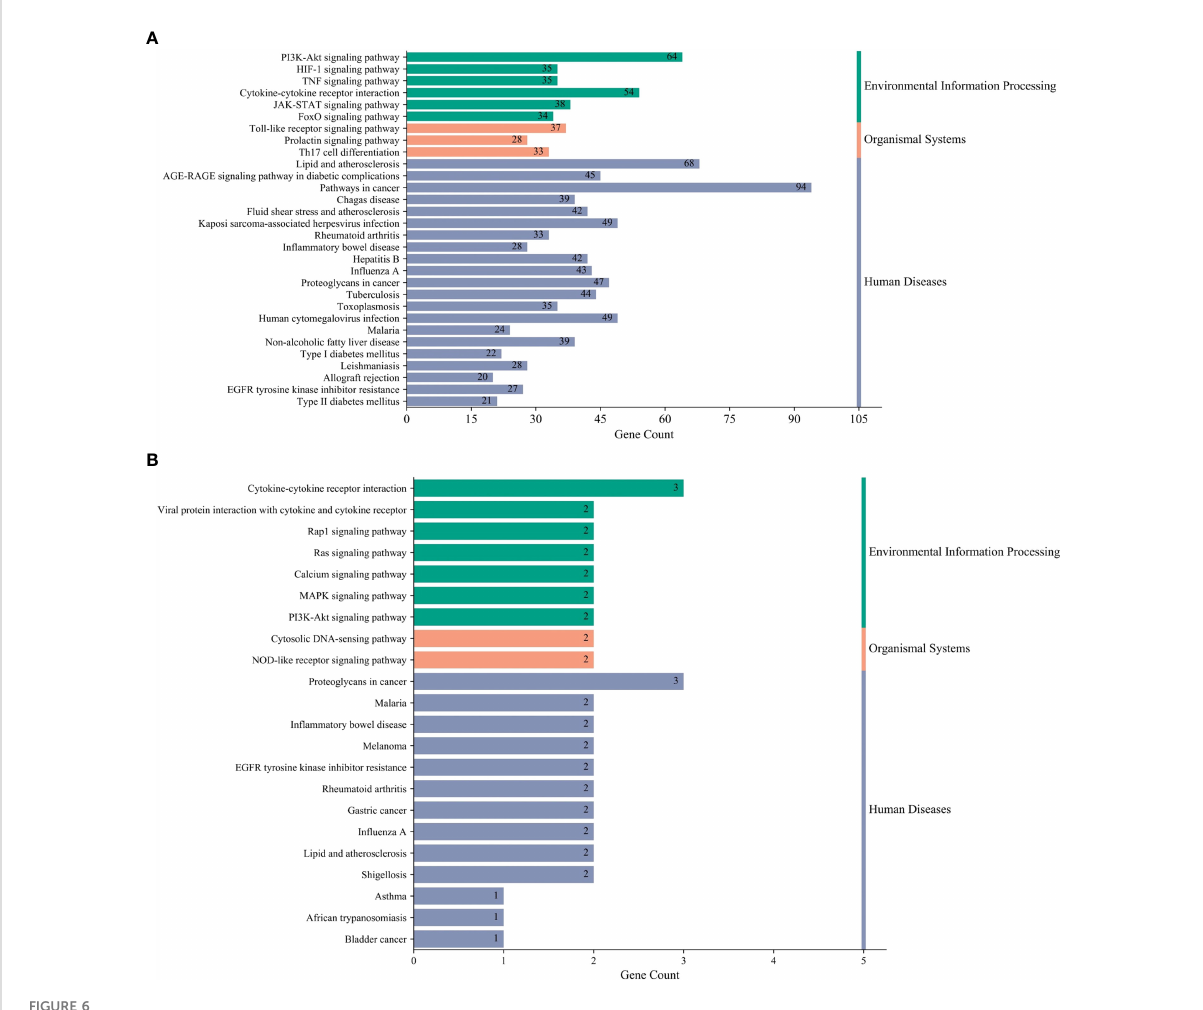
FIGURE 6 Kyoto Encyclopedia of Genes and Genomes (KEGG) terms. (A) The most relevant KEGG terms in all risk genes of DKD complicated with IBD. (B) The most relevant KEGG terms in the key risk genes of DKD complicated with